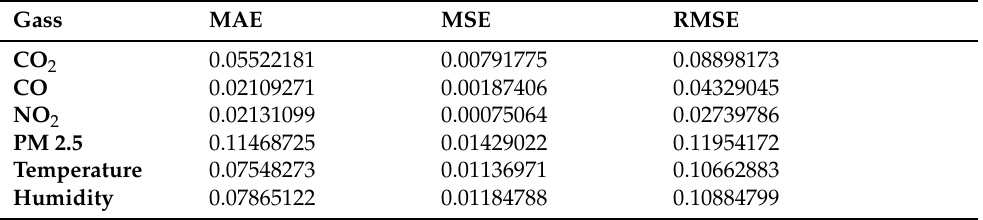
Table 2. Performance Evaluation of the Long and Short Term Memory (LSTM) for every 5 min.